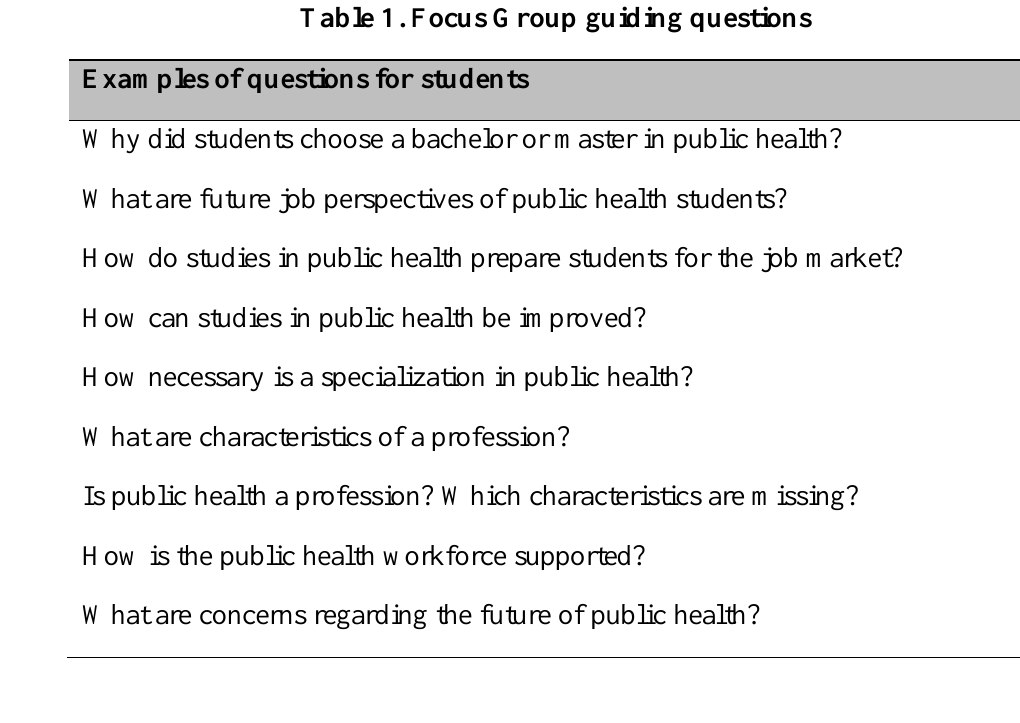
Table 2. Individual interview guiding